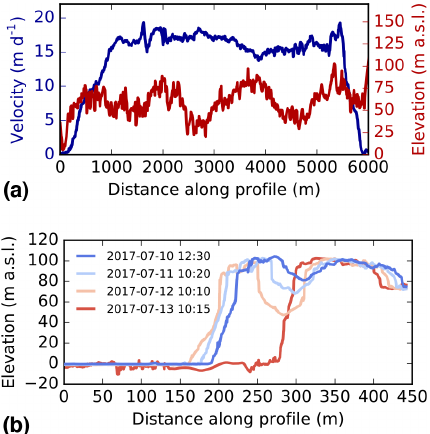
Figure 4. (a) Transect of A–A (cid:48) in Fig. 3a, displaying velocity (blue) and elevation (red). (b) Transect of B–B (cid:48) in Fig. 3a, displaying ele- vation profiles of the calving front through the study period. A large- scale calving event occurs between 12 and 13 July.